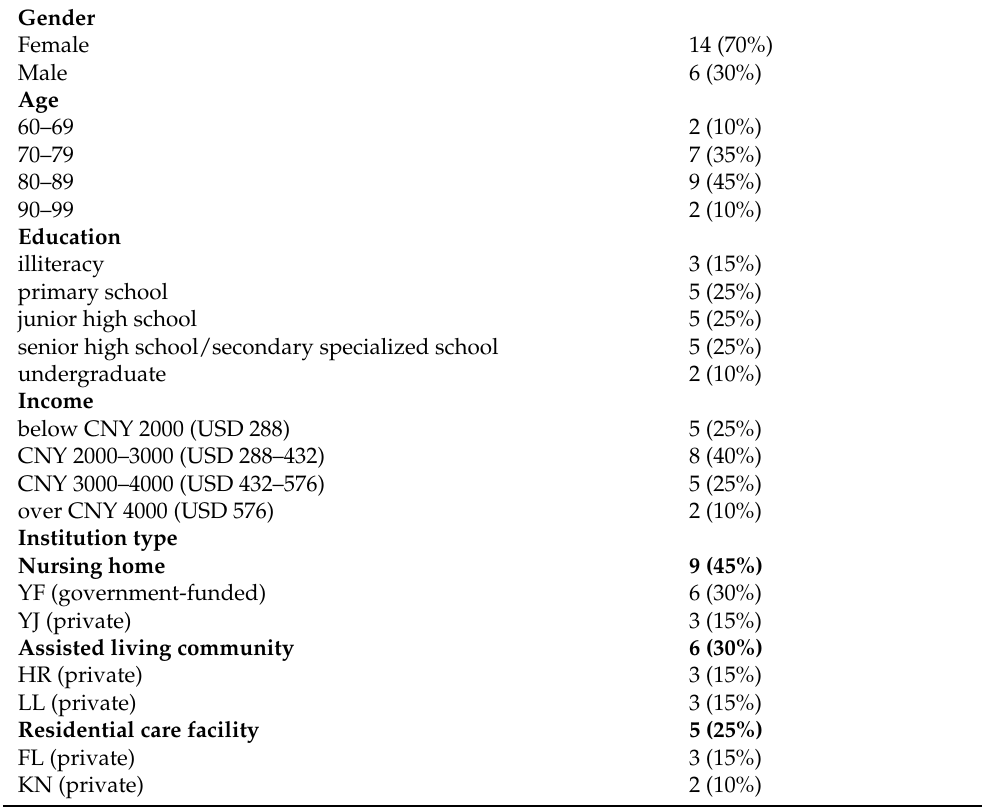
Table 1. Sample characteristics of the older individuals (n = 20).